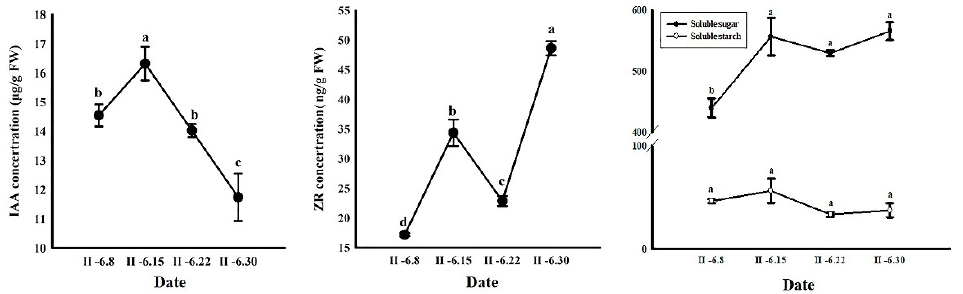
Figure 2. IAA, ZR, soluble sugar, and starch contents in Korean pine ovules before and tion. Error bars indicate the SD of three biological replicates. Lowercase letters represent significant after fertilization. Error bars indicate the SD of three biological replicates. Lowercase let- differences at p < ters represent significant differences at p < 0.05 .